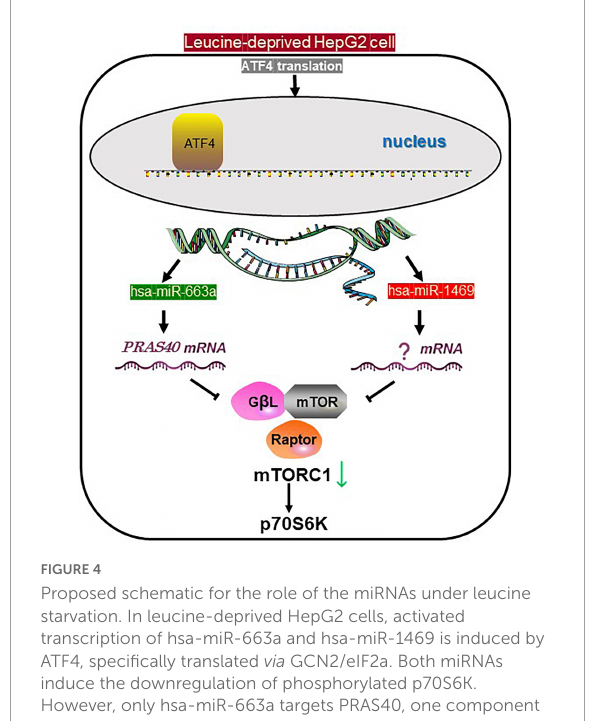
FIGURE4 Proposed schematic for the role of the miRNAs under leucine starvation. In leucine-deprived HepG2 cells, activated transcription of hsa-miR-663a and hsa-miR-1469 is induced by ATF4, specifically translated via GCN2/eIF2a. Both miRNAs induce the downregulation of phosphorylated p70S6K. However, only hsa-miR-663a targets PRAS40, one component of mTORC1, and inhibits mTORC1 activity. mTORC1, mechanistic target of rapamycin complex 1; p70S6K, P70S6 kinase 1; ATF4, transcription factor 4; GCN2, general control non-derepressible 2; eIF2a, eukaryotic translation initiation factor 2A; G β L, G-protein